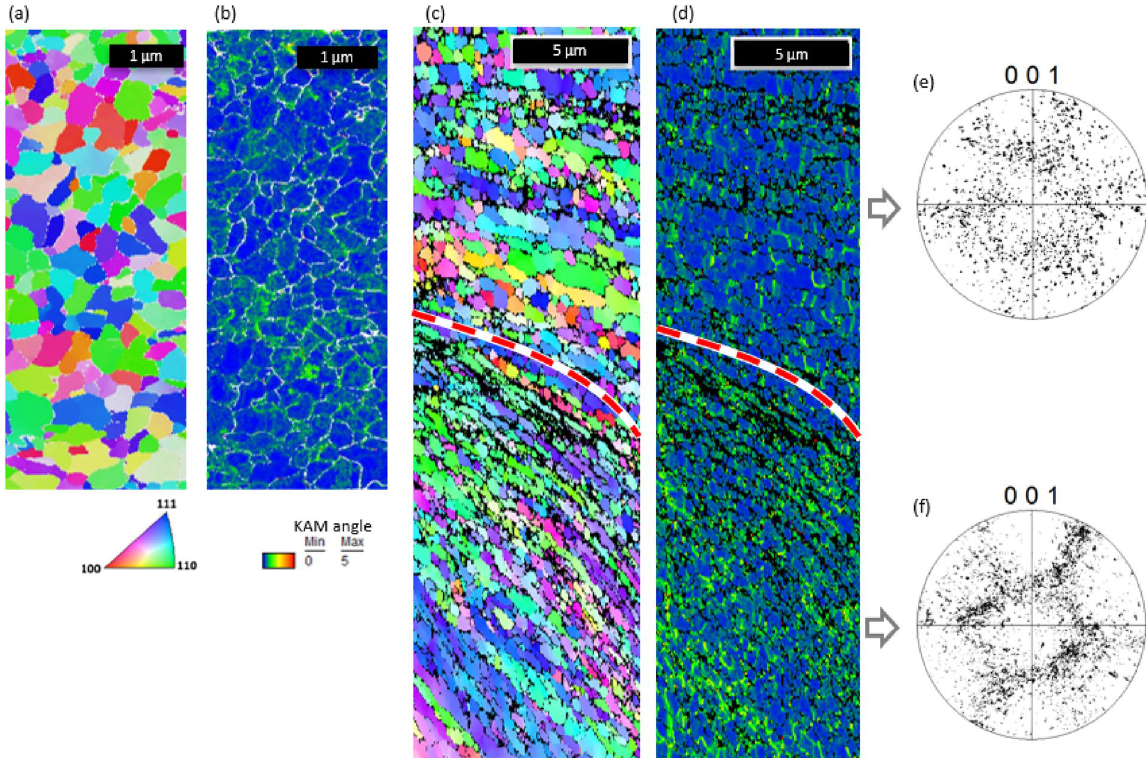
Figure 3. Crystallographic orientation by EBSD on frictioning surface (top corresponds to chip-tool contact surface) on chips cut at 200 m/min. ( a ) Inverse pole figure (IPF) colored in the proximity of the surface and ( b ) corresponding Kernel average misorientation (KAM) map. ( c ) IPF and ( d ) KAM of the whole area affected by friction. ( e ) and ( f ) are pole figures (PF) of the area inside and outside of the DRX layer respectively.